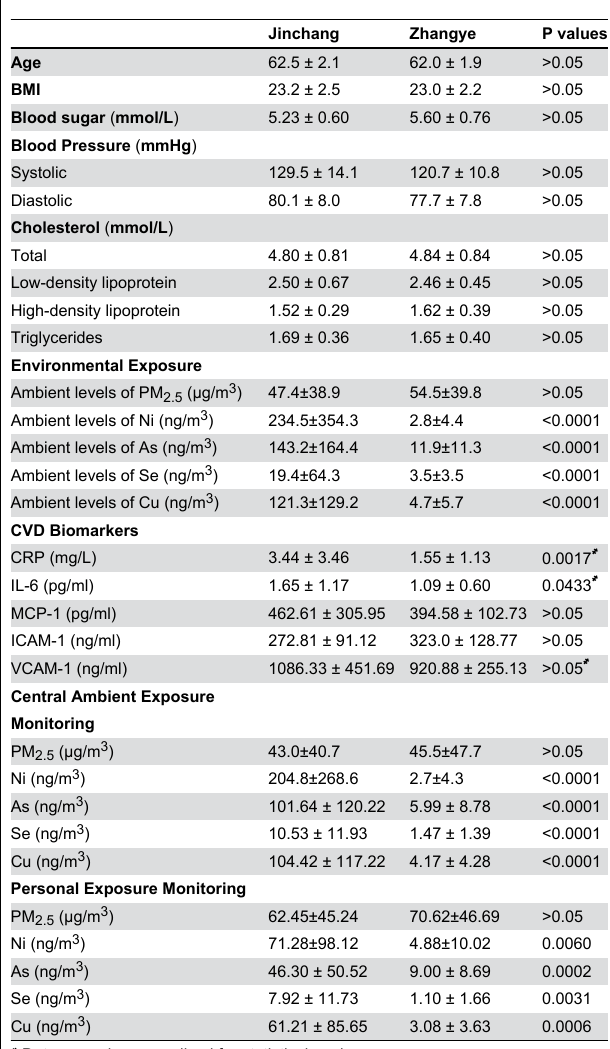
Table 3. Characteristics of all 60 Subjects, Environmental 2.5 Exposure, and CVD Biomarkers